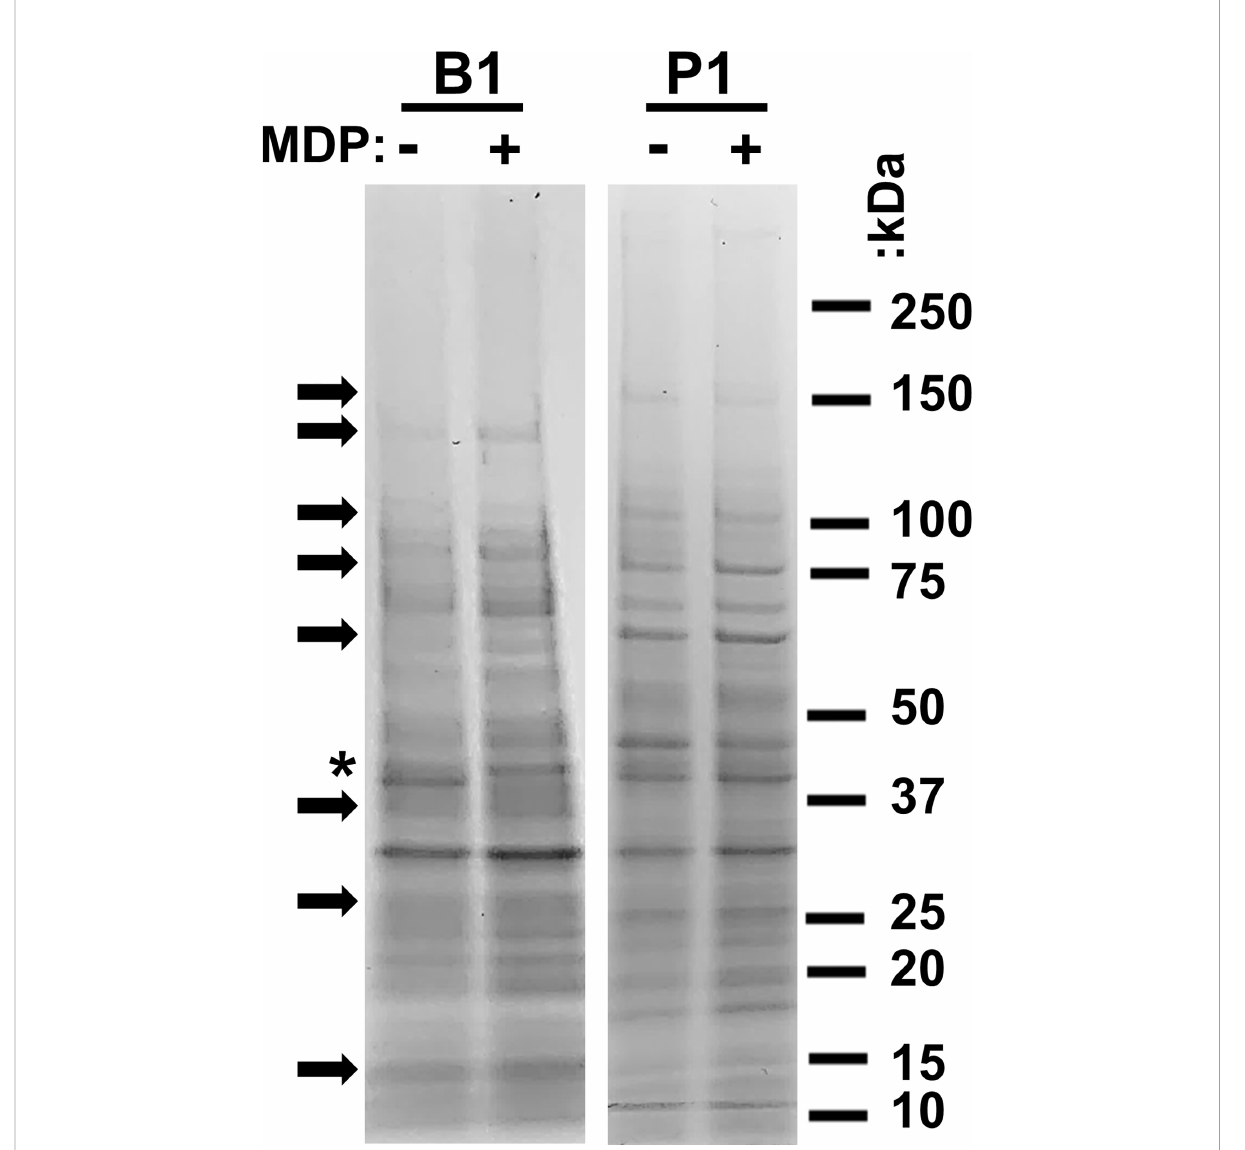
FIGURE 2 Analysis of immunogen protein pro fi les. B1 and P1 cultures of AB5075 were inactivated with UVC with (+) and without ( – ) the protective MDP complex. 1 x 10 8 bacterial cells were denatured in SDS-PAGE sample buffer and electrophoresed in a 4-20% polyacrylamide gel. Samples were then stained with Coomassie Brilliant Blue to visualize the total protein pro fi les of the four samples. Migration of molecular weight markers is shown to the right of the fi gure. Arrows indicate prominent differences between the B1 and P1 preparations. An asterisk highlights the one prominent exception at 40 kDa in samples prepared without